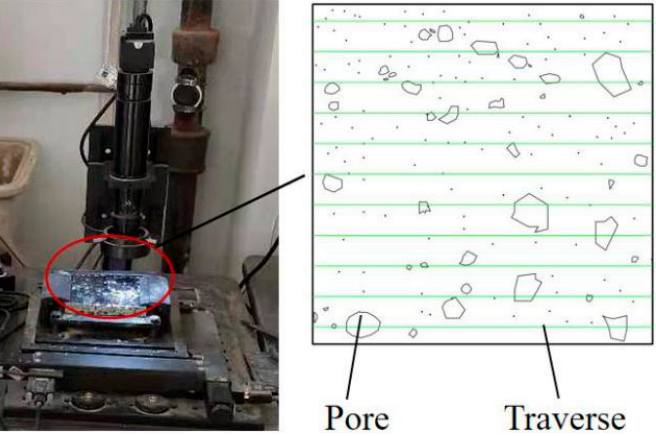
Figure 6. The hardened concrete hole structure analyzer and the traverses.